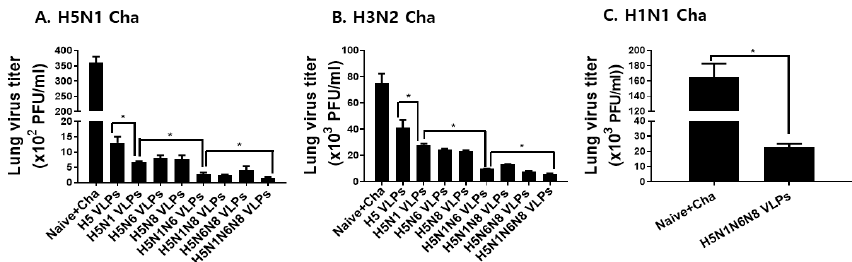
Figure 7. Lung virus titers upon influenza viruses challenge infection. VLP immunized mice were challenge infected with H5N1 ( A ), H3N2 ( B ), or H1N1 ( C ) influenza viruses. On day 4, lung samples were obtained and the lung virus titers were determined using MDCK cells. All data are expressed as mean ± SD (* p < 0.05).